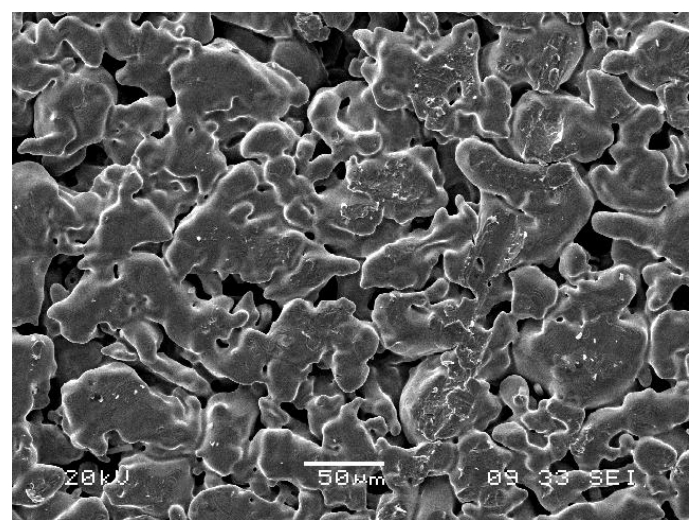
Figure 2. SEM image of porous metal